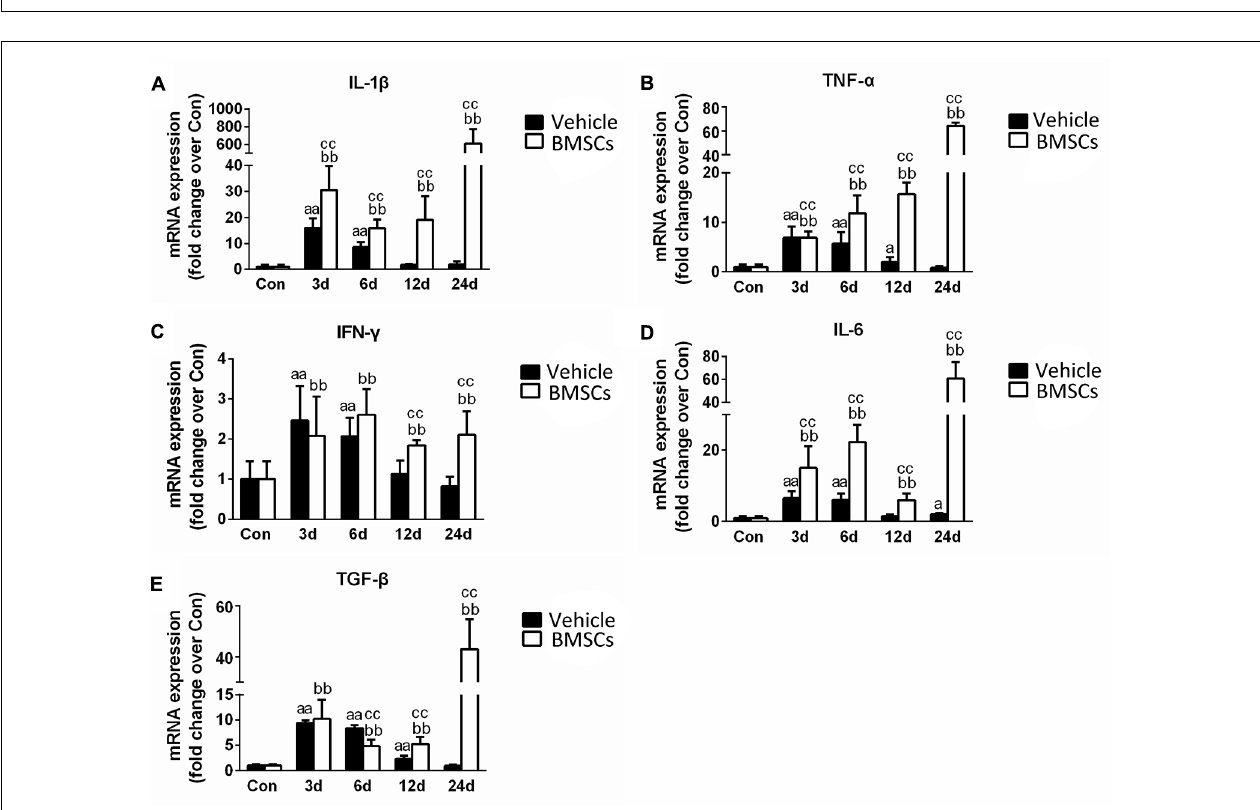
FIGURE 7 | The effects of BMSCs treatment on the expression of inflammatory cytokines. Vehicle, muscle contusion and Vehicle treated group; BMSCs, muscle contusion and BMSCs-treated group. (A–E) The expression of inflammatory cytokines after skeletal muscle injury. Data are means ± S.D., n = 8; a Significant difference from control, P < 0.05; aa P < 0.01. b Significant difference from control, P < 0.05; bb P < 0.01. c Significant difference from the same time points of group vehicle, c P < 0.05; cc P < 0.01. BMSCs transplantation enhanced the inflammatory response in skeletal muscle